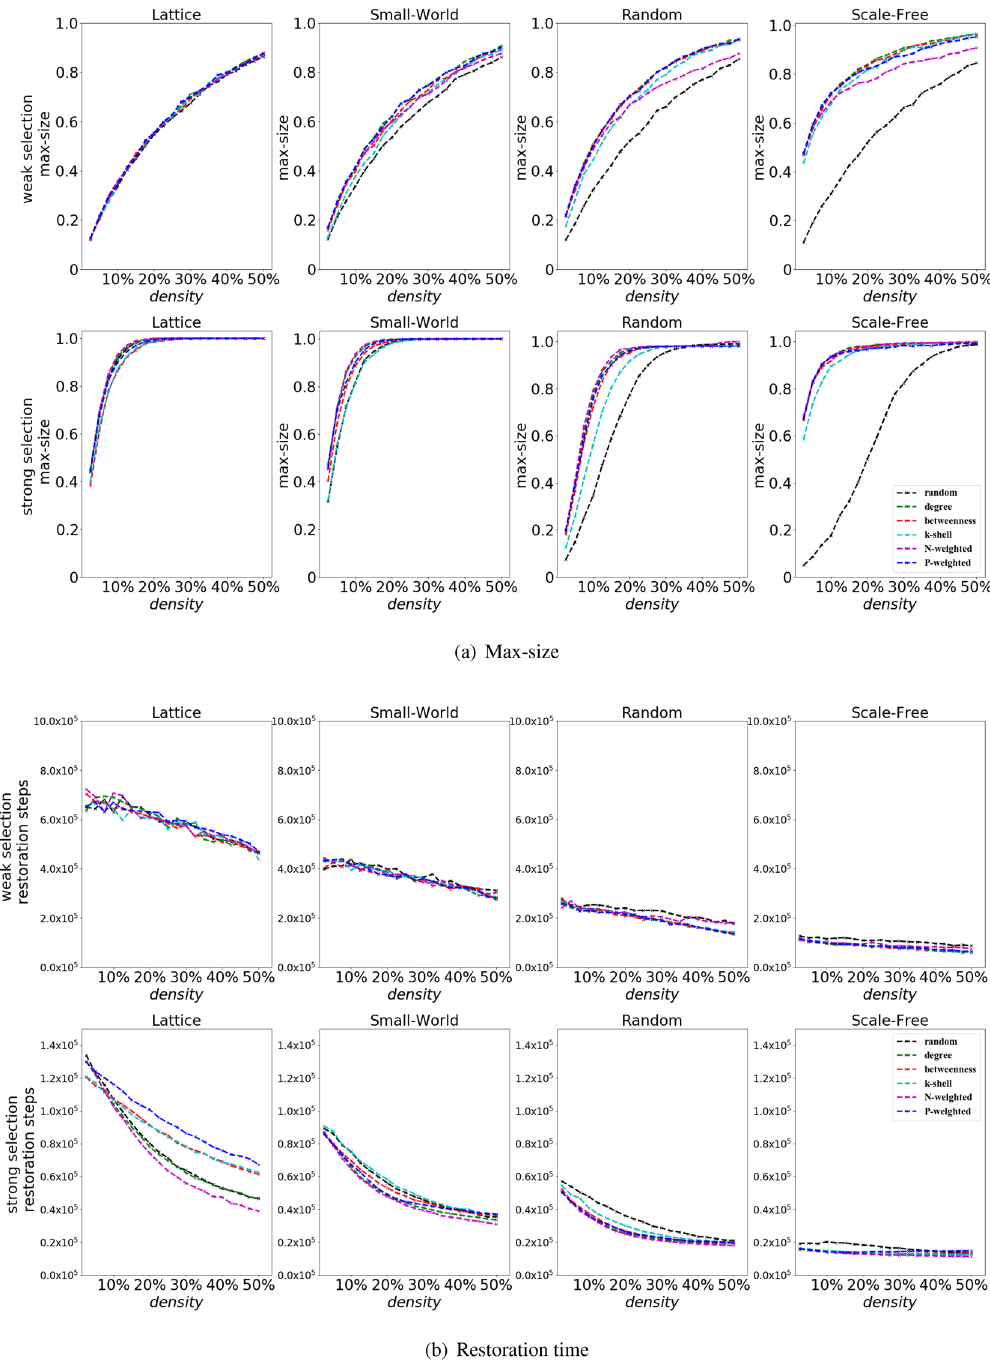
Figure 6. The max-size and restoration time for different initial densities ρ . A larger max-size of cooperators and a smaller restoration time (i.e., which corresponds to a faster restoration of cooperation) are obtained by using the N-weighted degree ranking, especially in the lattice and at strong selection. The random ranking works worse (in scale-free networks) than the structural rankings. We consider a stag-hunt game (with S = − 0.5 and T = 0.5 ), and a lattice, small-world, random and scale-free networks, for weak selection ( w = 0.001 ) and strong selection ( w = 0.1